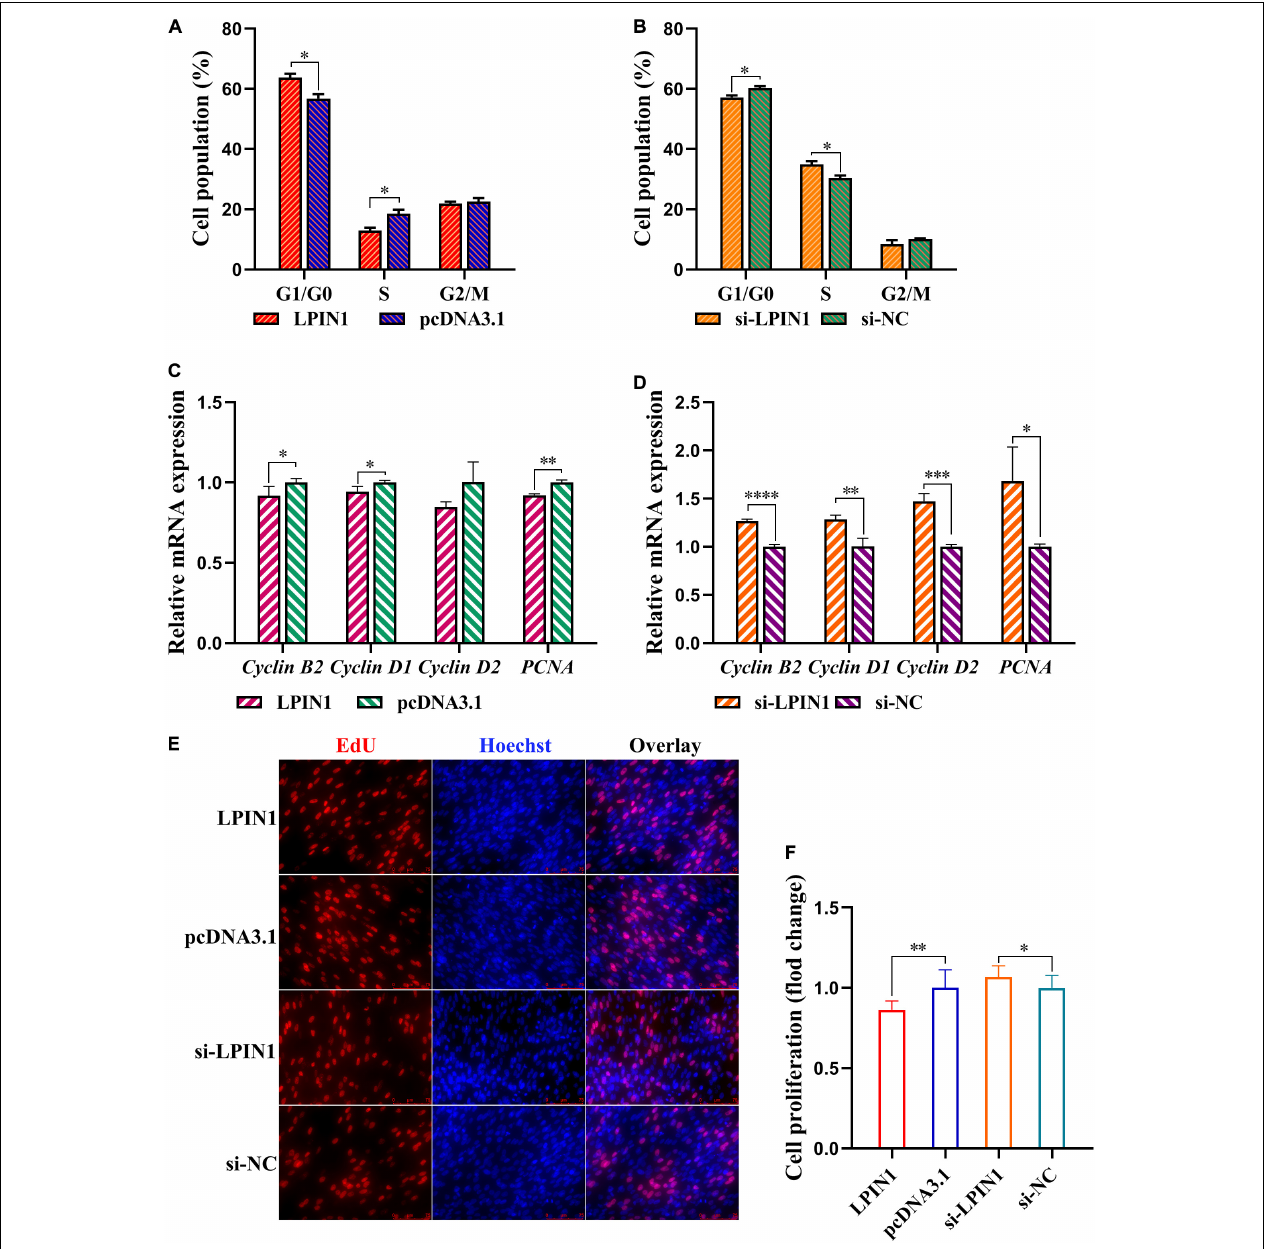
FIGURE 8 | LPIN1 suppresses preadipocytes proliferation. (A,B) Flow cytometry for cell cycle detection of ICP-1 cells. (C,D) Relative mRNA expression of Cyclin B2 , Cyclin D1 , Cyclin D2 , and PCNA in ICP-1 cells. (E,F) EdU staining for cell proliferation of ICP-1 cells. Data presented as mean ± SEM, * P < 0.05; ** P < 0.01; *** P < 0.001; **** P < 0.0001; ns: no